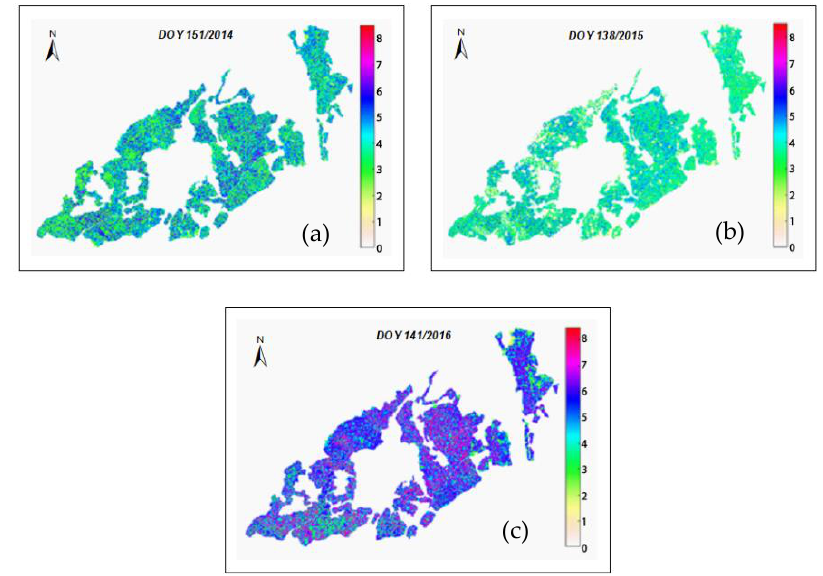
Figure 7. Doukkala irrigation scheme: actual evapotranspiration ET a estimated by applying SEBAL to multispectral L8/OLI, TIRS image data in May: ( a ) reference year 2013–2014, ( b ) wet year 2014–2015, and ( c ) dry year 2015–2016.